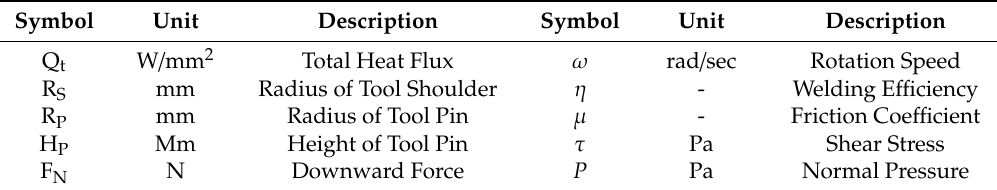
Table 2. Design variables for heat source calculation.